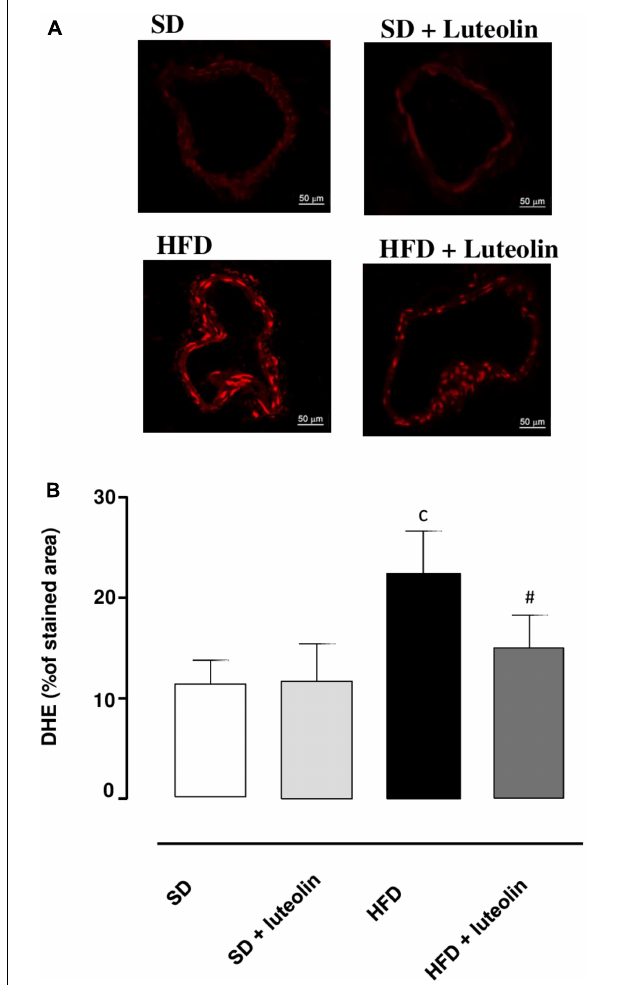
FIGURE 5 | (A) Representative dihydroethidium (DHE) staining and (B) quantitative analysis (bar graph) of the red signal in mesenteric arteries (magnification × 40) from mice fed with SD, SD plus treatment with luteolin (10 mg/Kg/day), HFD or HFD plus treatment with luteolin (10 mg/Kg/day) for 8 weeks. Each column represents the mean ± SEM of five animals. c P < 0.001, significant difference vs. SD; # P < 0.001 significant difference vs. HFD. Statistics: two-way analysis of variance followed by Newman–Keuls